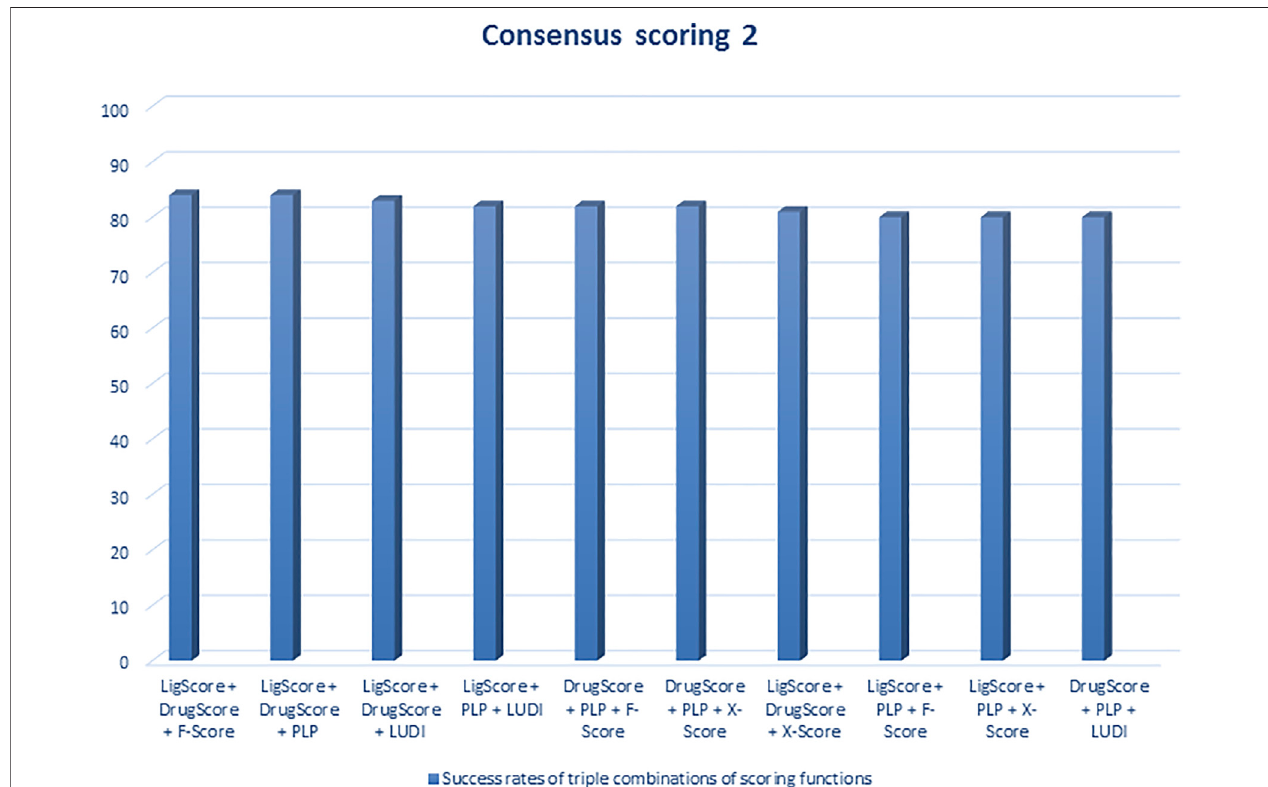
FIGURE 2 | Success rates of triple combinations of the six relatively successful scoring functions in consensus scoring. All numbers are in percent (R. Wang et al., 2003).